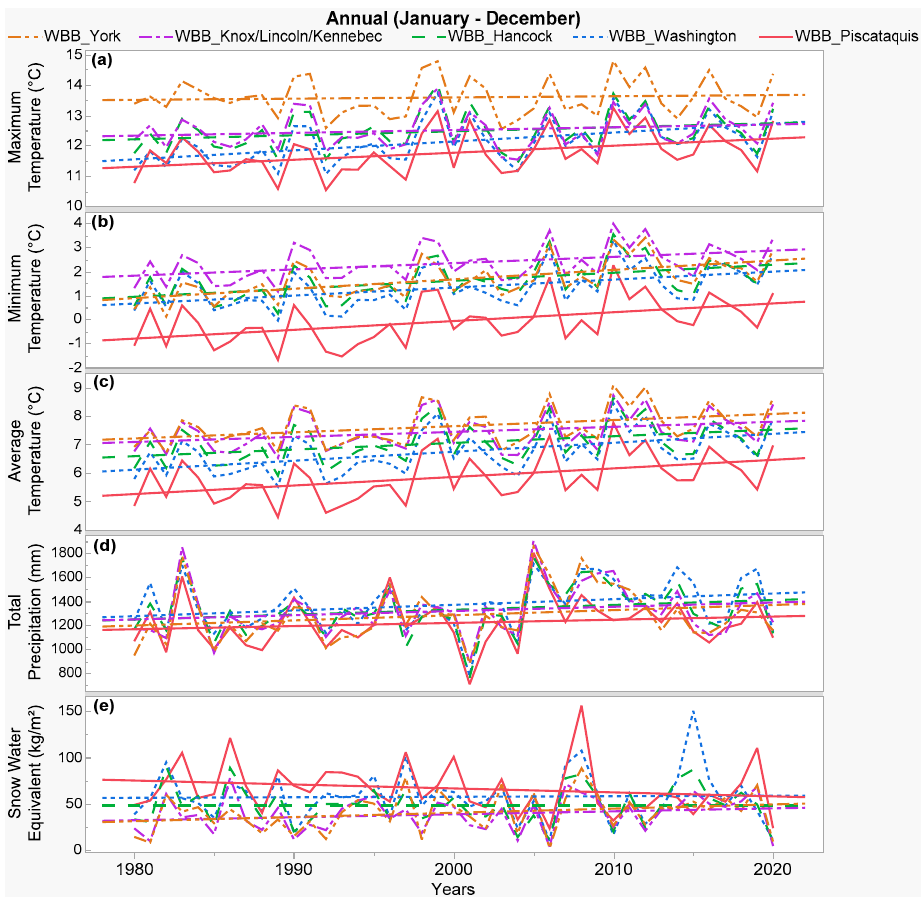
Figure 3. Historical (1980 to 2020) changes with fitted linear regression trendlines for the annual climate parameters: ( a ) maximum temperature, ( b ) minimum temperature, ( c ) average temperature, ( d ) total precipitation, and ( e ) snow water equivalent throughout the studied wild blueberry barrens (WBBs) in different counties from north-central (Piscataquis) and north-east (Washington, Hancock) to south-west (Knox, Lincoln, Kennebec, York) of Maine as shown in Figure 1. Table 1. Historical trend analysis of annual climate variables using Mann–Kendall test, and comparison of linear regression fitted slopes using slope t -test among the studied wild blueberry barrens (WBBs) in different counties from north-central (Piscataquis) and north-east (Washington, Hancock) to south-west (Knox, Lincoln, Kennebec, York) of Maine (shown in Figure 1) from 1980 to 2020. Red-colored parts indicate significant strength in historical climate trends. Different letters associated with the “Slope rate” indicate significant differences among the counties at a significance level of p < 0.05. Different letters “a–d” after the numbers indicate significant differences among the studied barrens in different counties. Climate Variables